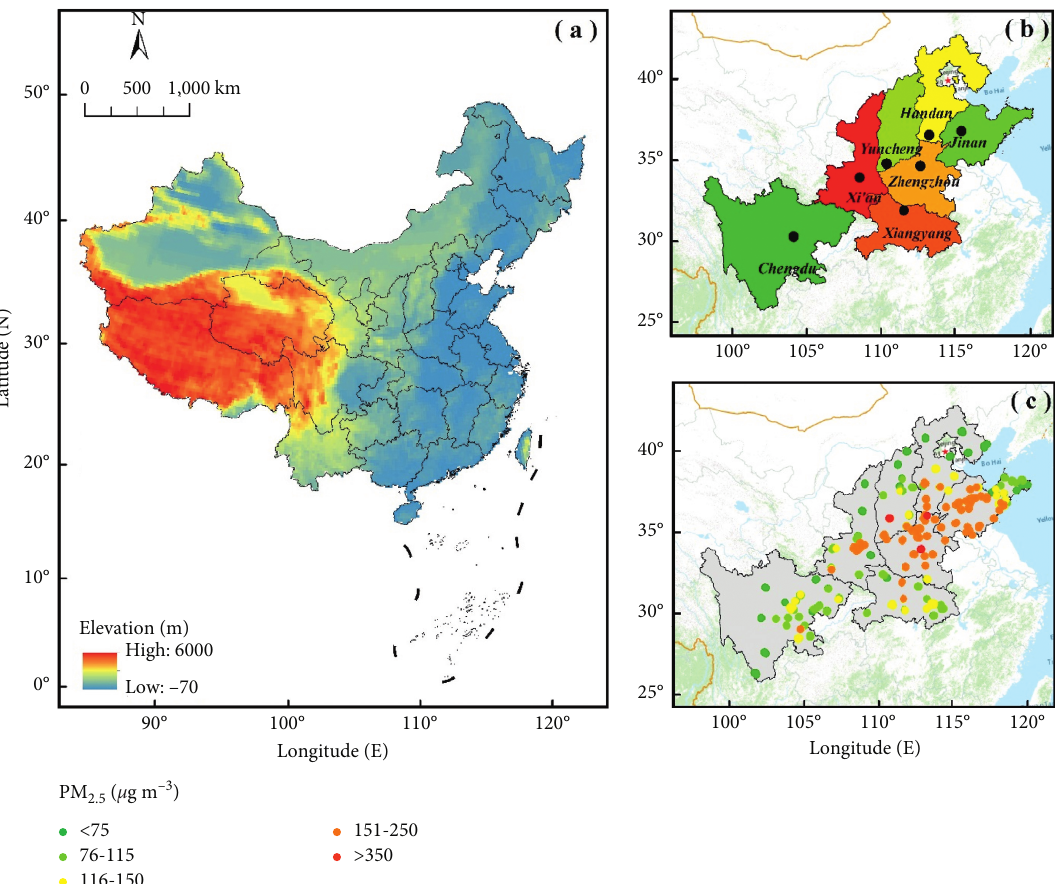
2.5 monitoring stations